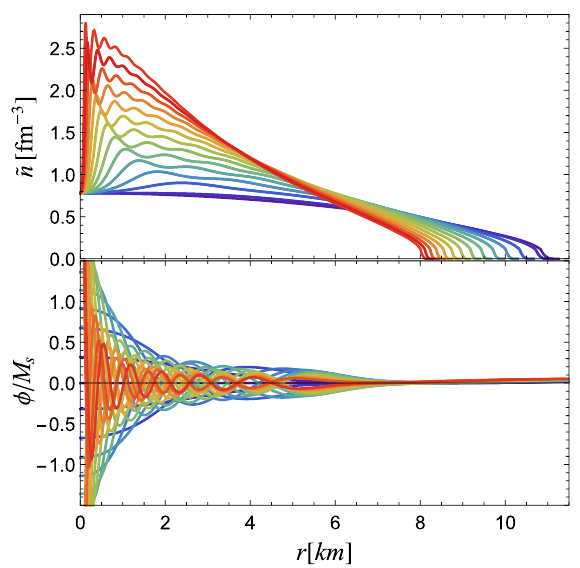
Figure 4. Number density (upper panel) and scalar field (bottom panel) as functions of the radial coordinate, for SNSs with a central number density ˜ n c = 0.780 fm − 3 , in the quadratic variant of the symmetron model with M s / M Pl = 0.1. Twenty-six solutions with 0 ≤ n ≤ 12 are displayed, with the number n of nodes increasing from violet to